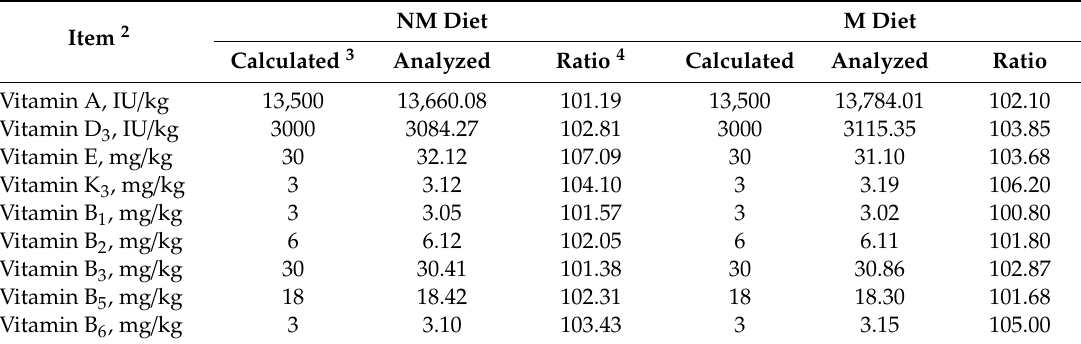
Table 4. Vitamin concentration in unmanufactured mash diet (as-fed basis) 1